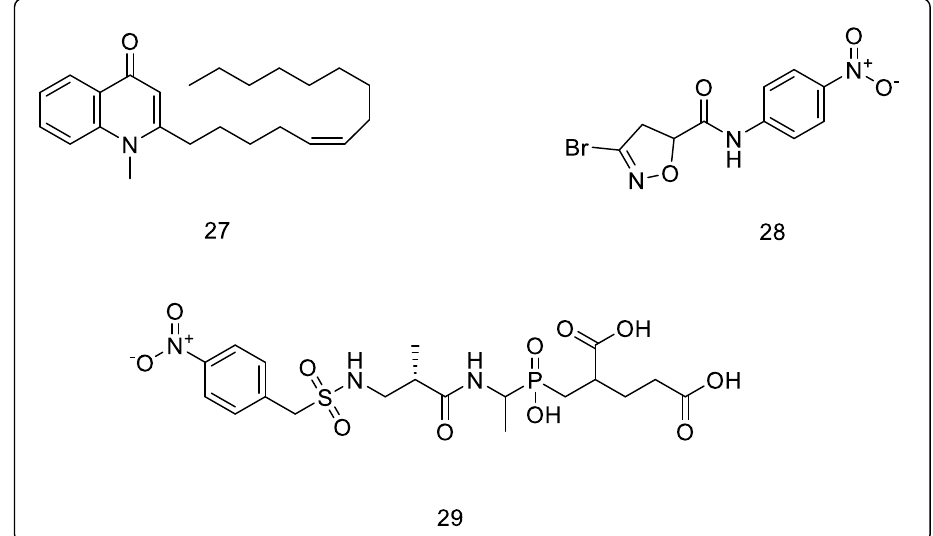
Figure 8. ( 27 ) N-methyl-2-alkenyl-4-quinolones, ( 28 ) 3-bromo-4,5-dihydroisoxazole, ( 29 ) phos- phinates as Mur inhibitors